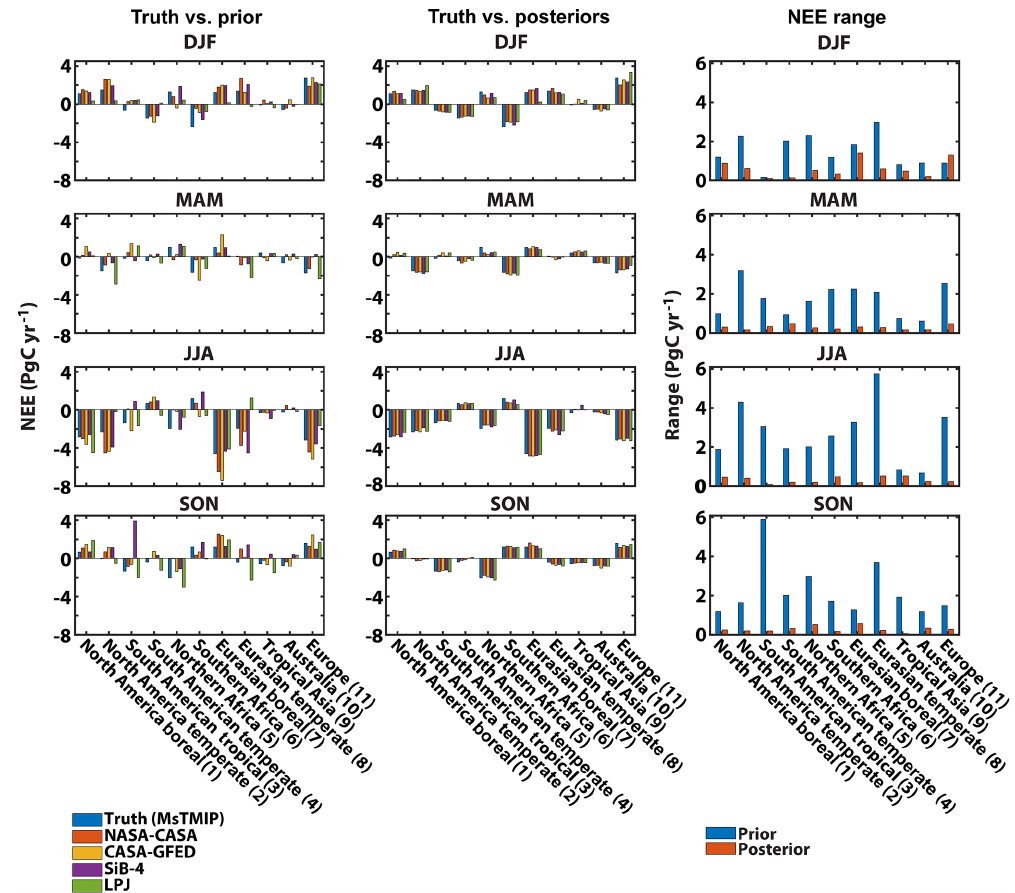
Figure 6. Seasonally averaged NEE averaged over the 11 TransCom-3 land regions from MsTMIP (truth) vs. the prior biosphere models (NASA-CASA, CASA-GFED, SiB-4, and LPJ) (left column), posterior estimates (middle column) from the OSSE simulations, and the corresponding range of prior and posterior NEE estimates (right column). The synthetic observations in these OSSE simulations correspond to the OCO-2 LN + LG observing modes. Detailed statistics of the truth, multi-model means of prior and posterior NEE estimates, standard deviations, and ranges displayed in this figure are listed in Table